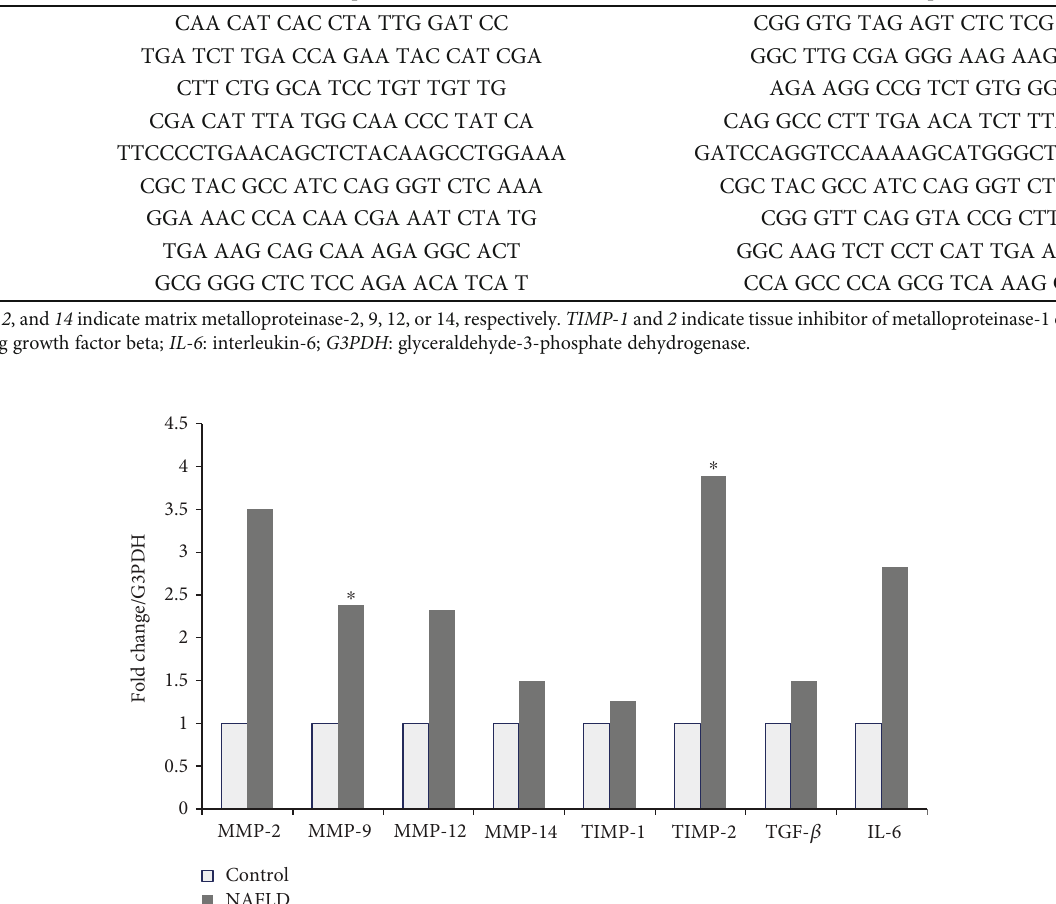
Table 2: Primer sequence of target genes and reference gene for SYBR Green real-time PCR.